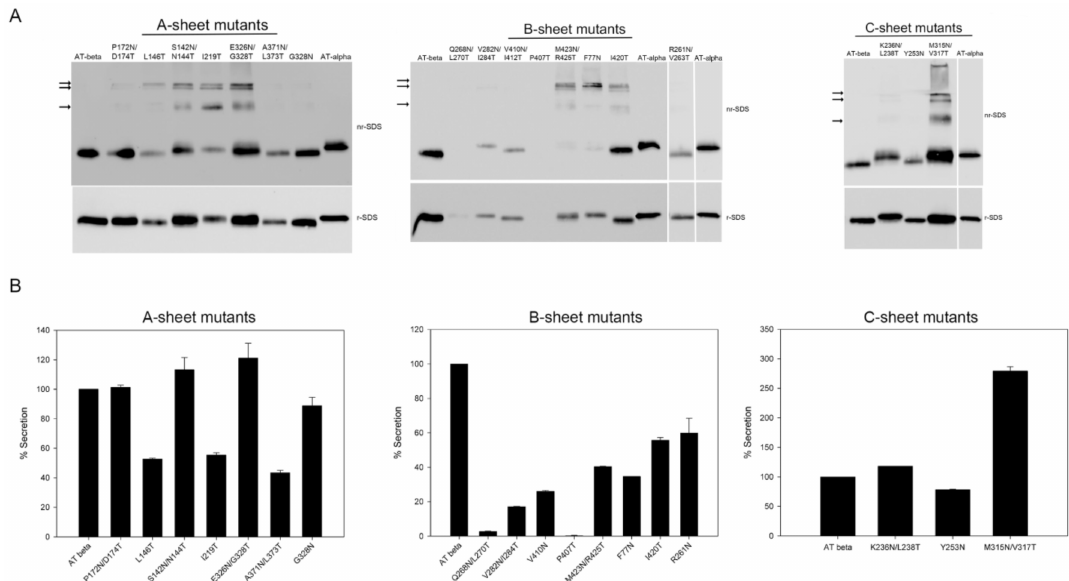
Figure 2. Secretion of mutant antithrombins. ( A ) SDS-PAGE under reducing and non-reducing conditions and Western blot of the medium after 48 h of transfection. ( B ) The rate of secretion of mutant antithrombins. The quantification of secretion was carried out by gel densitometry 48 h after transfection. Blots cropped from different gels are delineated with white space. Full-length gels are included in the Supplementary